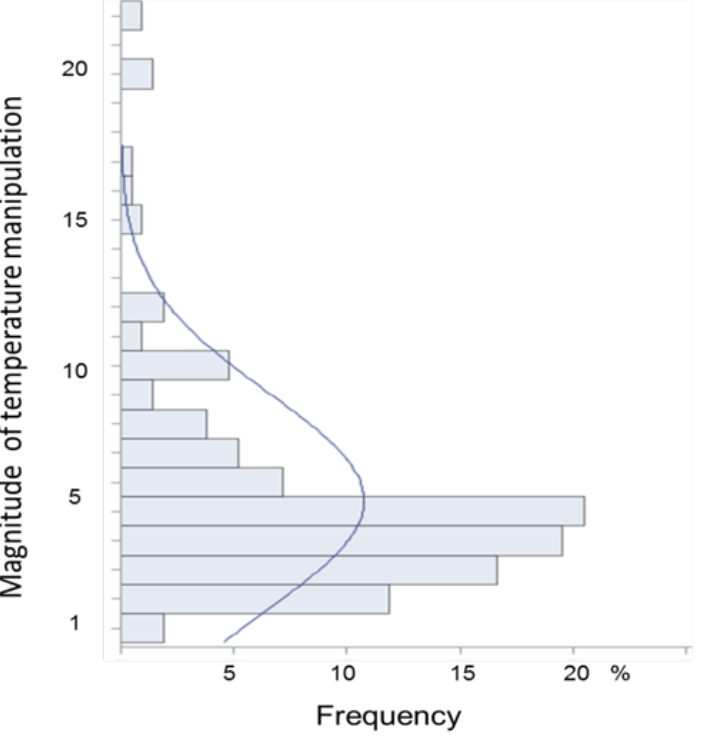
Figure 4. Magnitude of temperature manipulations in experimental studies of climate change impacts on biodiversity in freshwater and marine environments. Relative frequency distribution of the magnitude of temperature manipulations (based on data for 216 experimental studies). The magnitude of the temperature manipulation was calculated as the average temperature difference between treatments (for studies with fixed treatments) or as the change in temperature over time (for studies that used gradually increasing temperature treatments).